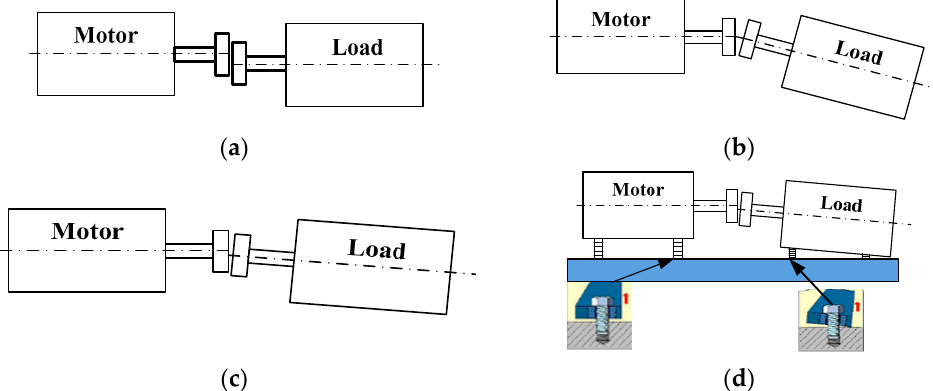
Figure 1. The incorrect installation of an induction motor. ( a ) shows a parallel misalignment arising from the motor shaft axis connected to the load in the same plane, and the center of motion of the shaft is parallel. ( b ) shows an angular misa- lignment arising from the axial motor shaft coupled with the load in the same plane, and the center of motion of the shaft is angular. ( c ) shows a combined misalignment arising from the axial motor shaft coupled with the load in the same plane, and the center of motion is parallel and angular. ( d ) shows the adjustment of the installed rotor shaft connected to a load calibrated with a dial gauge.